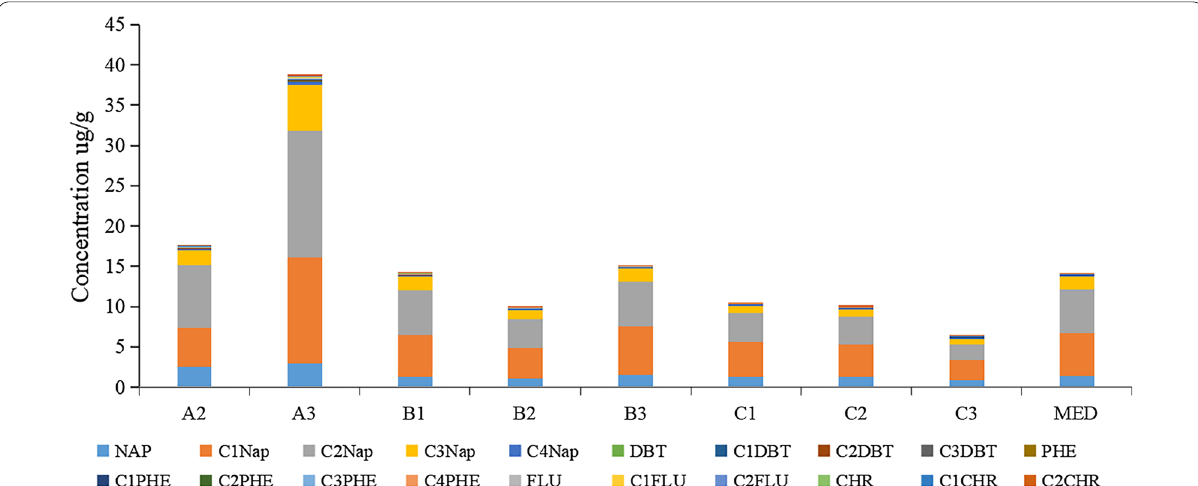
Fig. 4 The abundance of PAHs in sampling sediment analysis by GC–MS. The symbol An (Bn, Cn): the nst sampling site of line A (B, C); MED: control site in Jiaozhou Bay; SLR: control site in Shilaoren Beach, which was outside of Jiaozhou Bay. Internal standards were determined using p -terphenyl- D14 (10 μg/mL). The abundance of each PAH was calculated by the internal